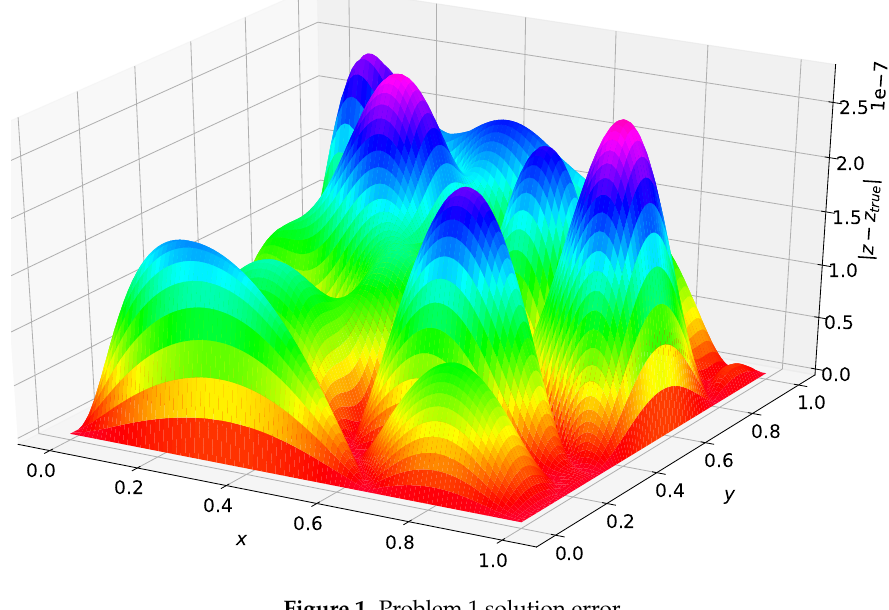
Figure 1. Problem 1 solution error.